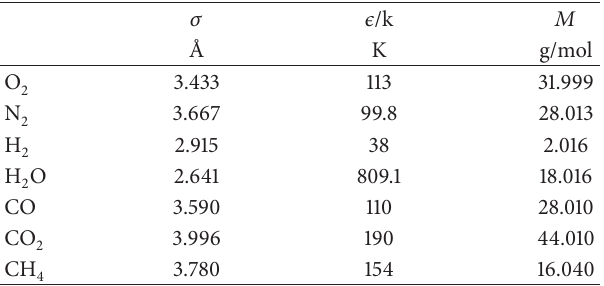
Table 3: Constants used for determining the binary diffusion coefficients [18,